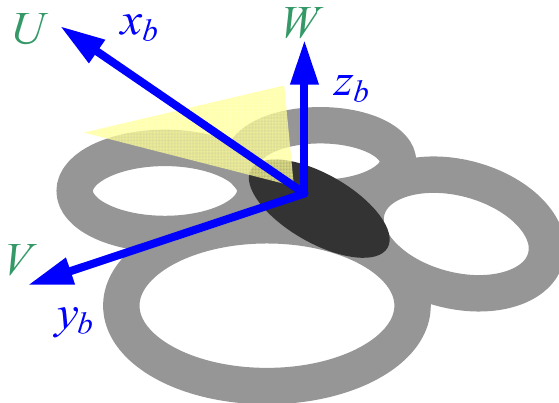
Figure 6. MUAV body coordinate system. (Yellow region: camera field of view).